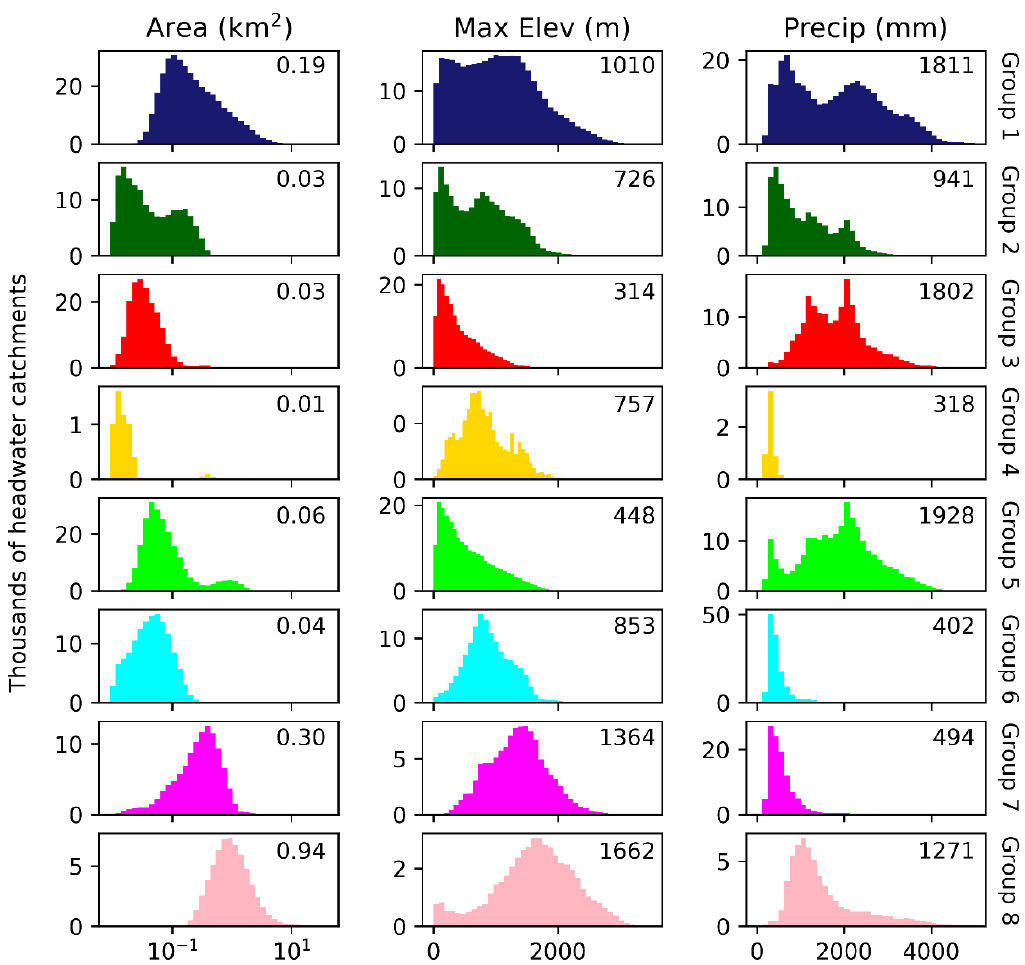
Figure 7. Distributions of drainage area (log scale), maximum elevation, and total annual precipitation for headwater catchments in each calibration group (Table 2). Median values are reported in the top-right corner of each histogram.